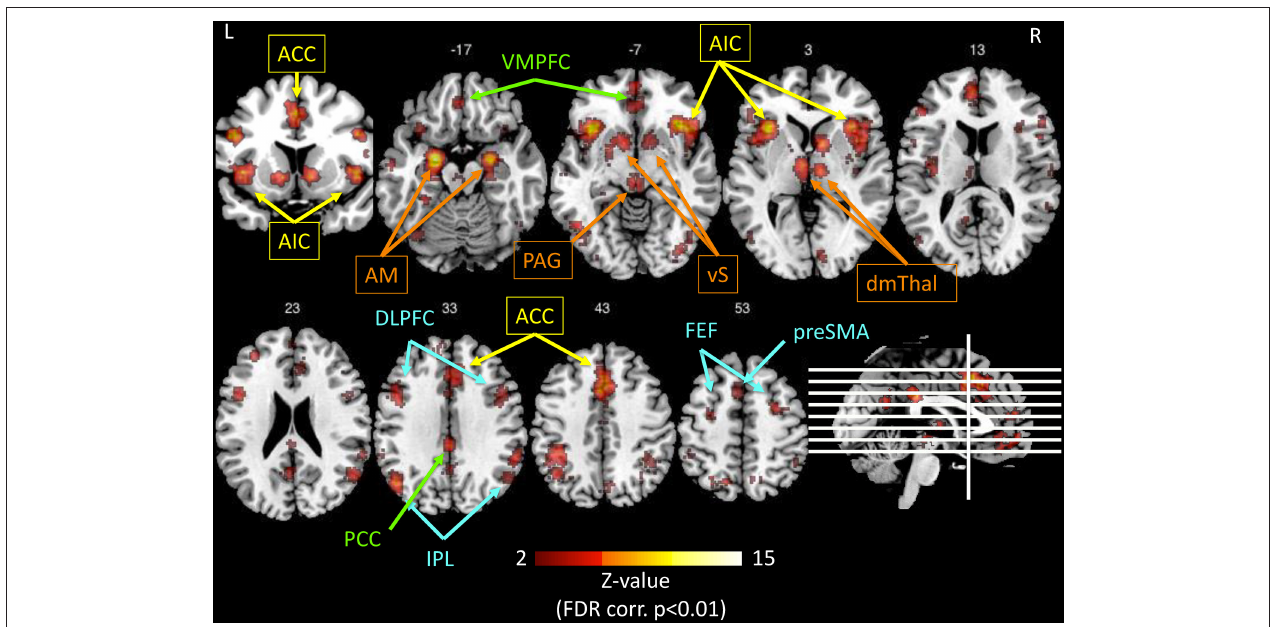
FIGURE 4 | Illustration of the networks implicated in salience processing, as obtained by the meta-analysis tool Neurosynth.org (Yarkoni et al., 2011), based on the results of 122 published studies, using the only keyword “salience” in forward inference, and displayed on a template anatomical T1 image with Z-values of 2 to 15 (using the Mango software package 2 ). The resulting significant regions ( p < 0.01 , FDR corrected) interestingly comprise four networks: Yellow: anterior cingulate cortex (ACC) and anterior insula (AI) represent the salience network (Seeley et al., 2007b). Orange: the extended insular network consisting of amygdala (AM), ventral striatum (vS), periaqueductal gray (PAG), and dorsomedial thalamus (dmTHal). Green: the PCC-VMPFC represents the default mode network ( Greicius et al., 2003). Blue: the fronto-parietal executive control network (Corbetta and Shulman, 2002; Fox et al., 2006). The salience network is thought to switch back and forth between the default mode network and executive control network ( Menon and Uddin, 2010; Uddin,